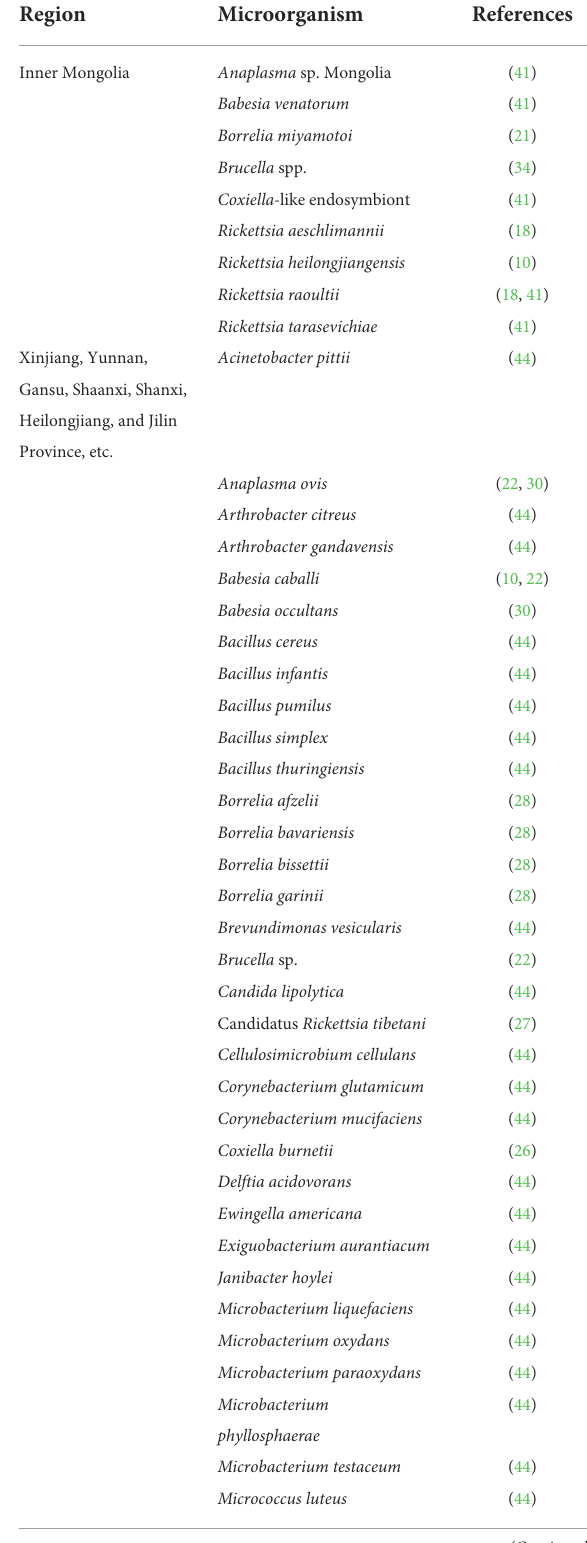
TABLE 1 Microorganisms carried by Dermacentor nuttalli in different geographical regions.